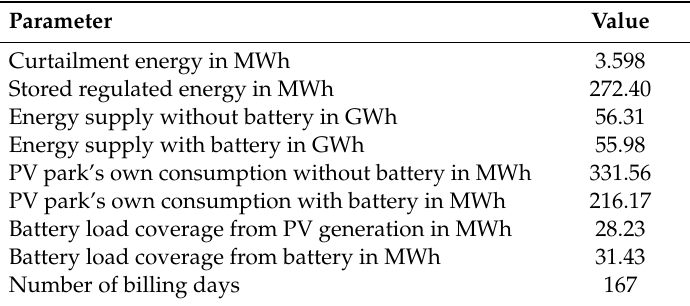
Table 6. Results for the adopted model.